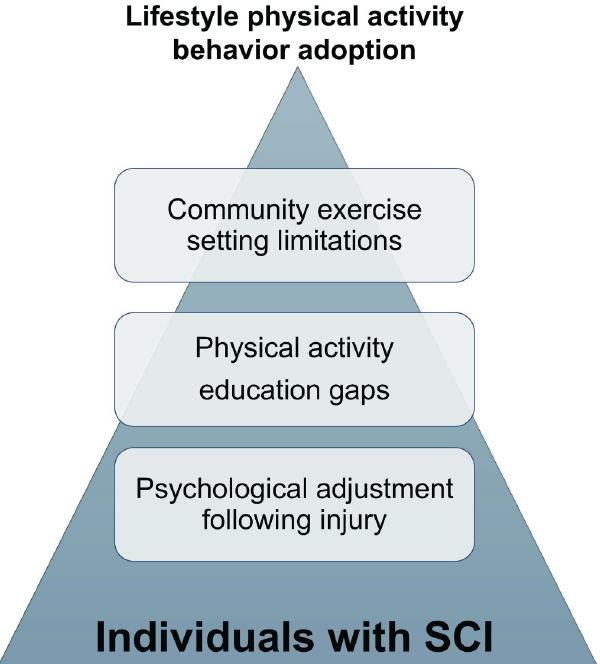
Fig 1. Challenges to physical activity lifestyle behavior adoption in individuals with SCI. Lifestyle physical activity adoption behavior is challenged by several personal and social factors including long-term psychological adjustment following spinal cord injury, gaps in physical activity education during community re-integration, and barriers in community exercise